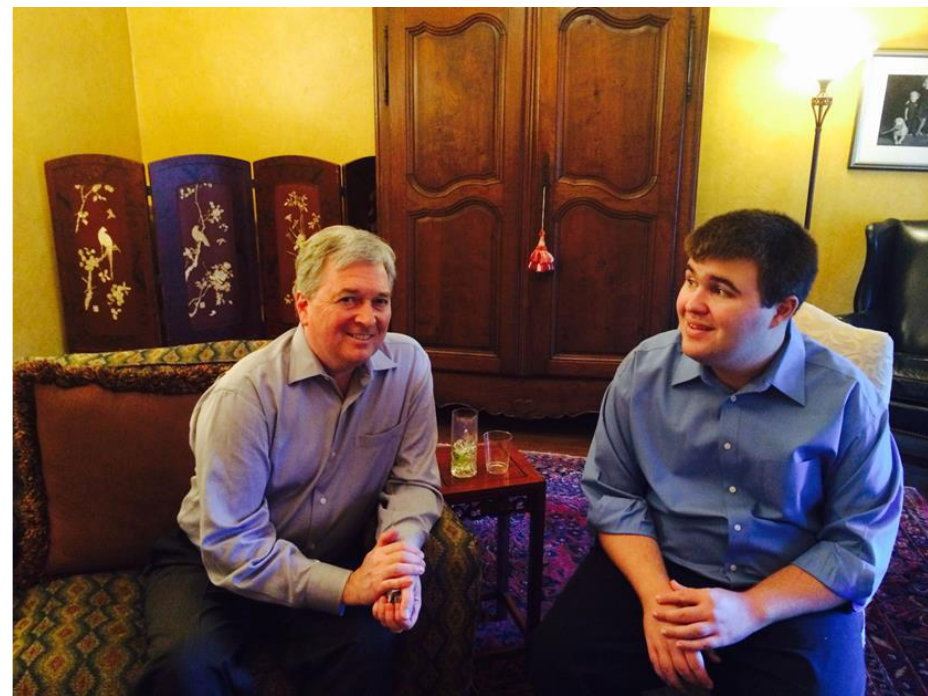
Figure 5: Keith Sartain and his son William. Courtesy: Sophie